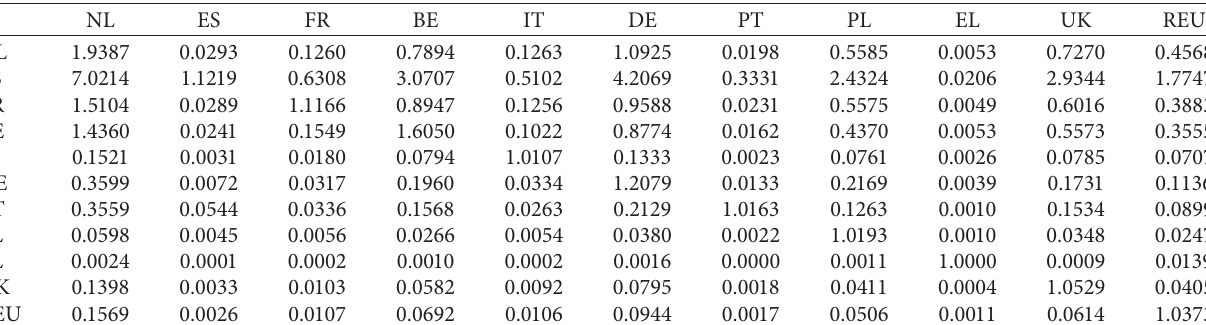
Table 9: Inverse matrix